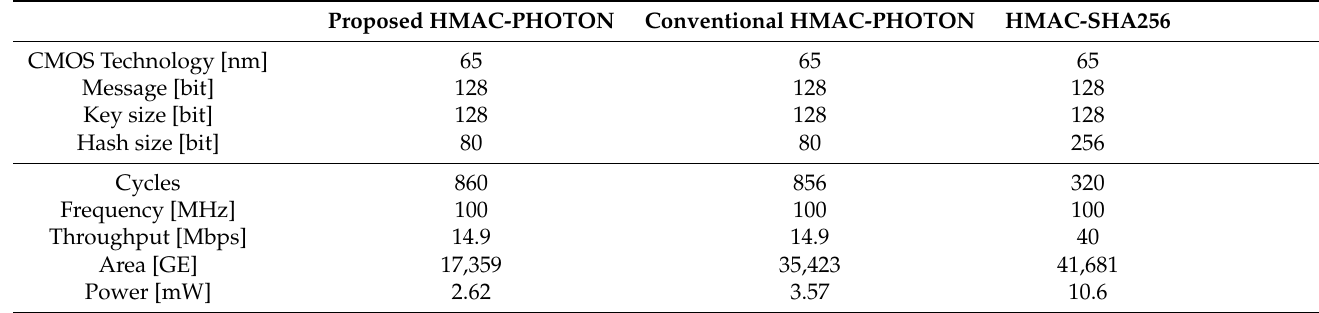
Table 2. Performance and security comparison of